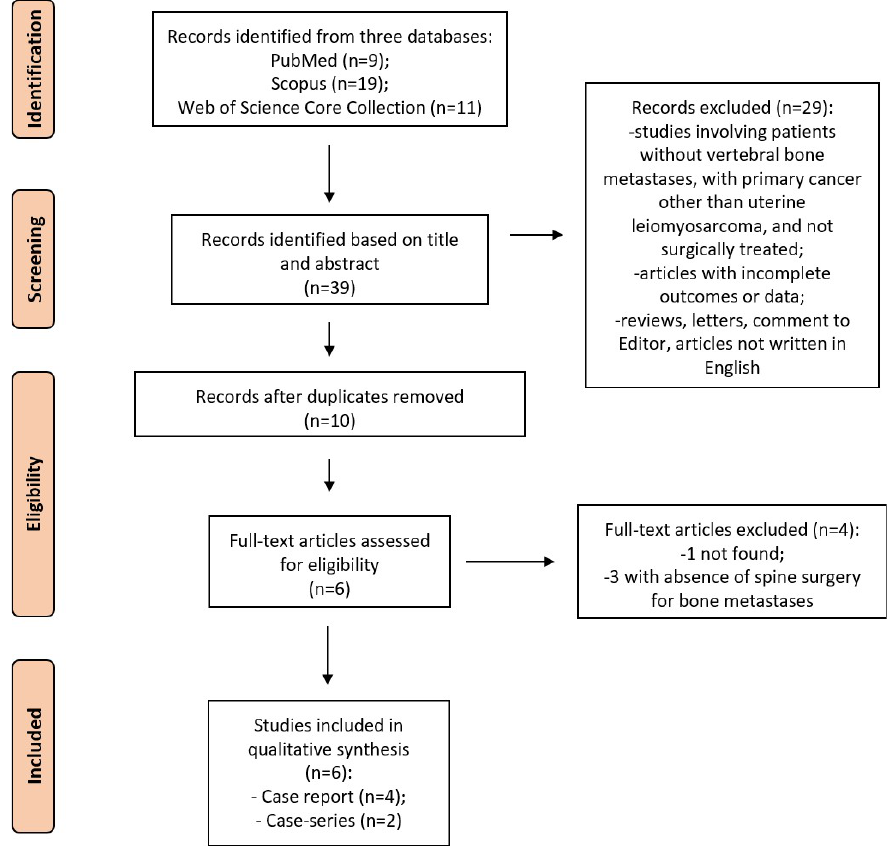
Figure 1. The PRISMA flow diagram for the systematic review detailing the database searches, the number of abstracts screened, and the full texts retrieved.